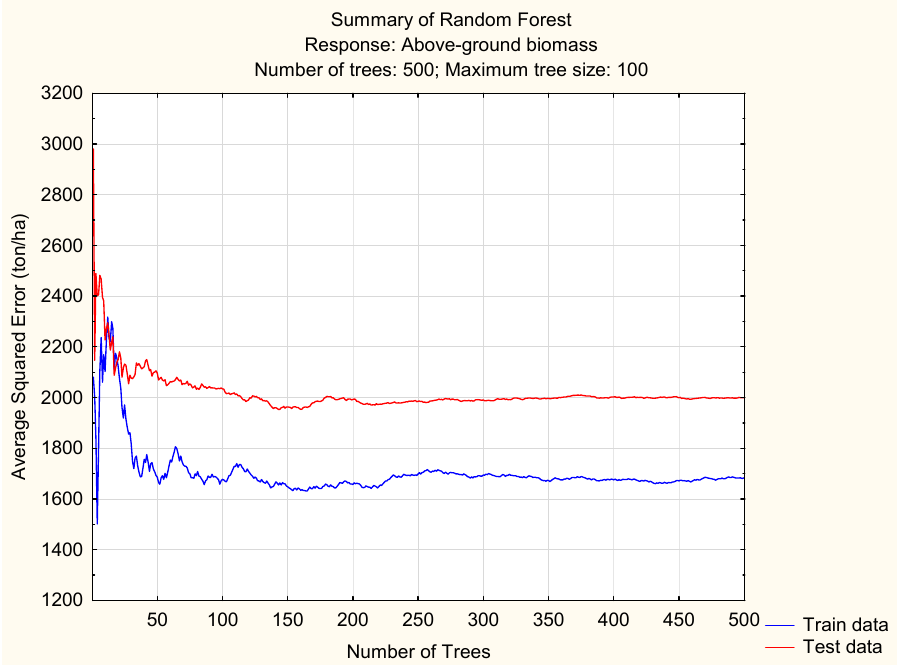
Figure 4. Random Forest error testing graph—the average squared error of aboveground biomass outputted by the Random Forest algorithm, plotted against the number of trees using the training and testing datasets.